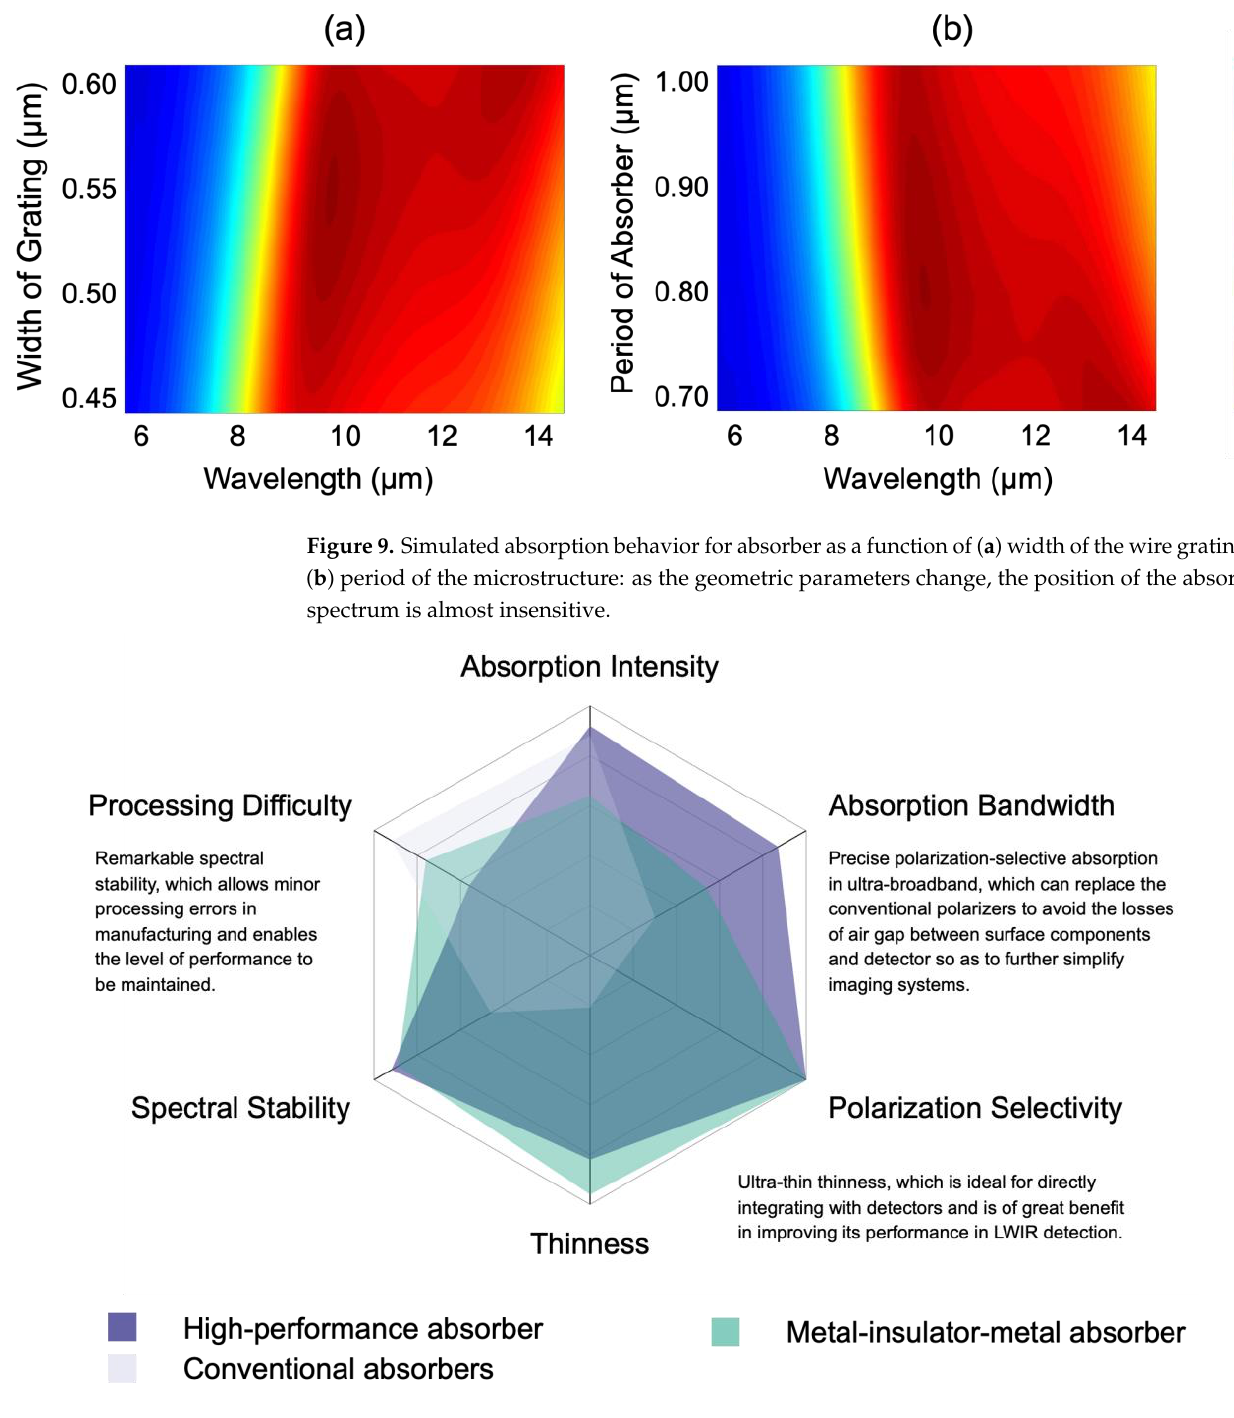
Figure 10. Performance assessment of the MIM absorber and high-performance absorber compared with a conventional absorber.